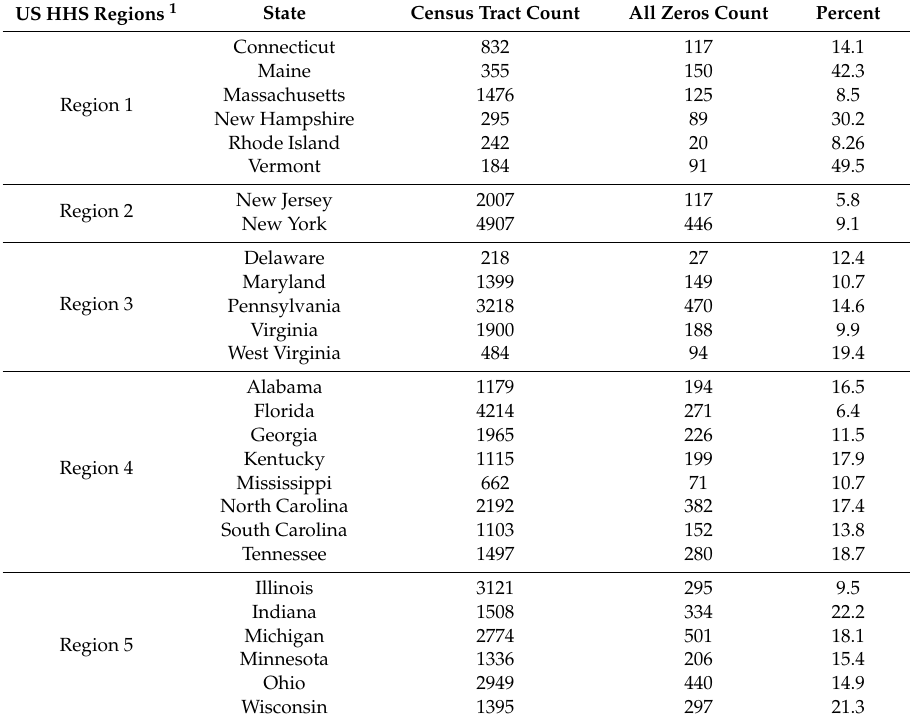
Table 2. Percentage of census tracts in rural areas not flagged for food access measures (US HHS Regions 1 through Region 5).